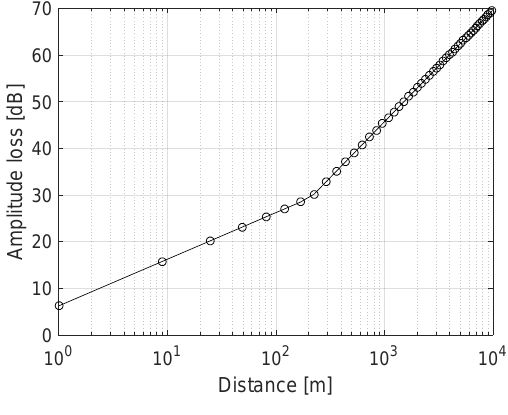
Figure 7. Amplitude loss of signal versus distance between ES and